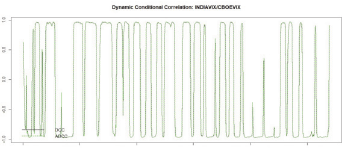
Fig. 3. Dynamic Conditional Correla- tion at D1 Scale